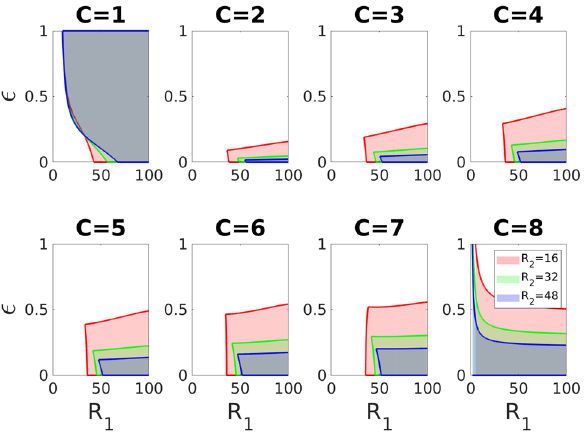
Figure 9. The equilibrium with C (> 0 ) equal cooperating groups exists and is locally stable when the benefit- to-cost ratio of the within-group game R 1 and the incumbency parameter ε lie in the shaded regions for different values of R 2 . Other parameters: ω = 0.1 , X 0 = 5 , c = 1 , Z 0 = 50 , π 0 = 1 , α = 1 , G = 8 and n = 10